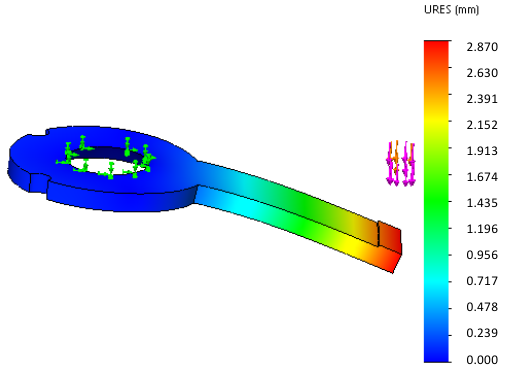
Figure 8. The finite element analysis result of the springs. The purple arrow indicates the force exerted on the spring. The pressure of the limited block is 100 N, which is calculated in Section 3. Then, the appropriate materials are selected and shown in Table